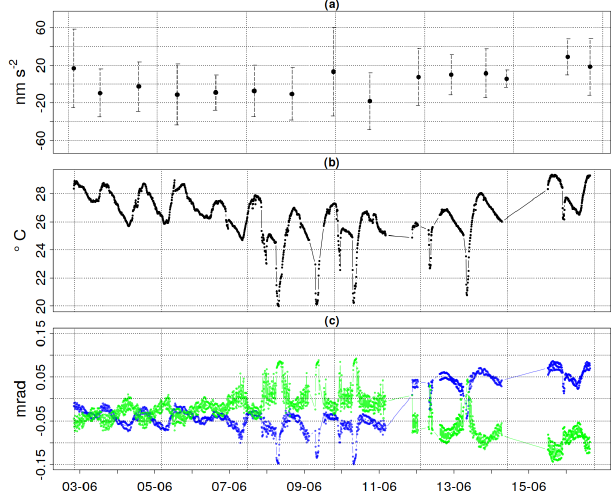
Figure 7. (a) AQG-B gravity residuals from the mean recorded dur- ing operation in a garage in Montpellier 2–17 June 2020. (b) Ex- ternal temperature in the garage recorded by AQG-B01 in degrees Celsius. (c) Sensor head tilts in x (blue) and y (green) given in mrad.